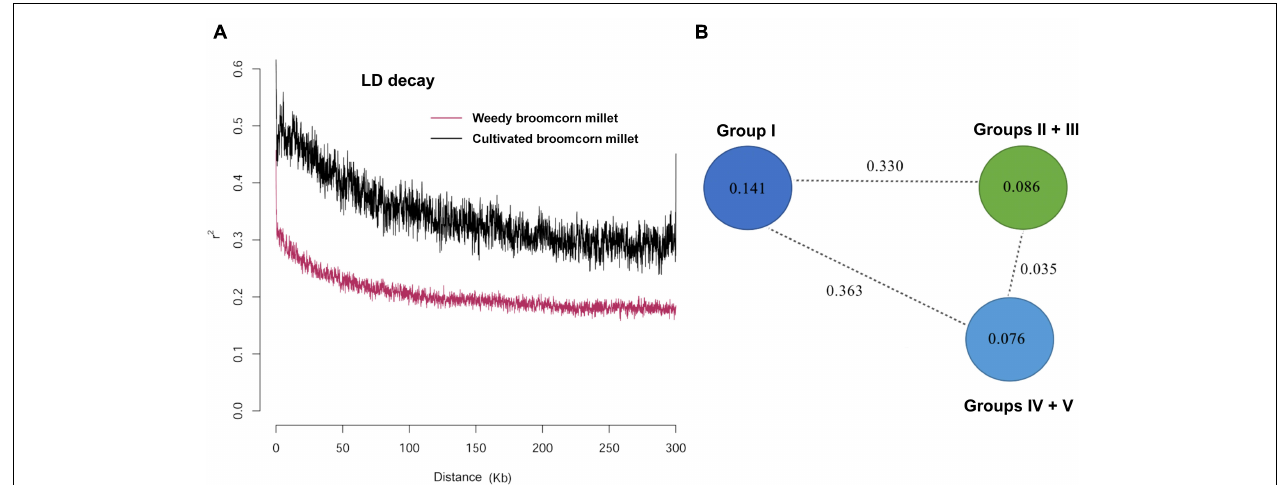
FIGURE 3 | Linkage disequilibrium (LD) in weedy and cultivated broomcorn millets and nucleotide diversity and divergence in Groups I to V identified by ADMIXTURE analysis of 106 accessions of broomcorn millets. (A) LD decay estimated by the coefficient of linkage disequilibrium (r 2 ) against the distance between polymorphic sites of weedy and cultivated broomcorn millet. (B) Nucleotide diversity ( π ) and fixation index ( F ST ) across Group I (including 7 weedy samples collected in China), Groups II + III (containing 52 cultivated samples mainly distributed in eastern Europe), and Groups IV + V (with 37 cultivated samples mainly distributed in central-western Europe). The π measurements of these groups are given in the circles and the value on each dashed line indicates the F ST value ( p < 0.001) between each pair of two groups at the ends of the line.